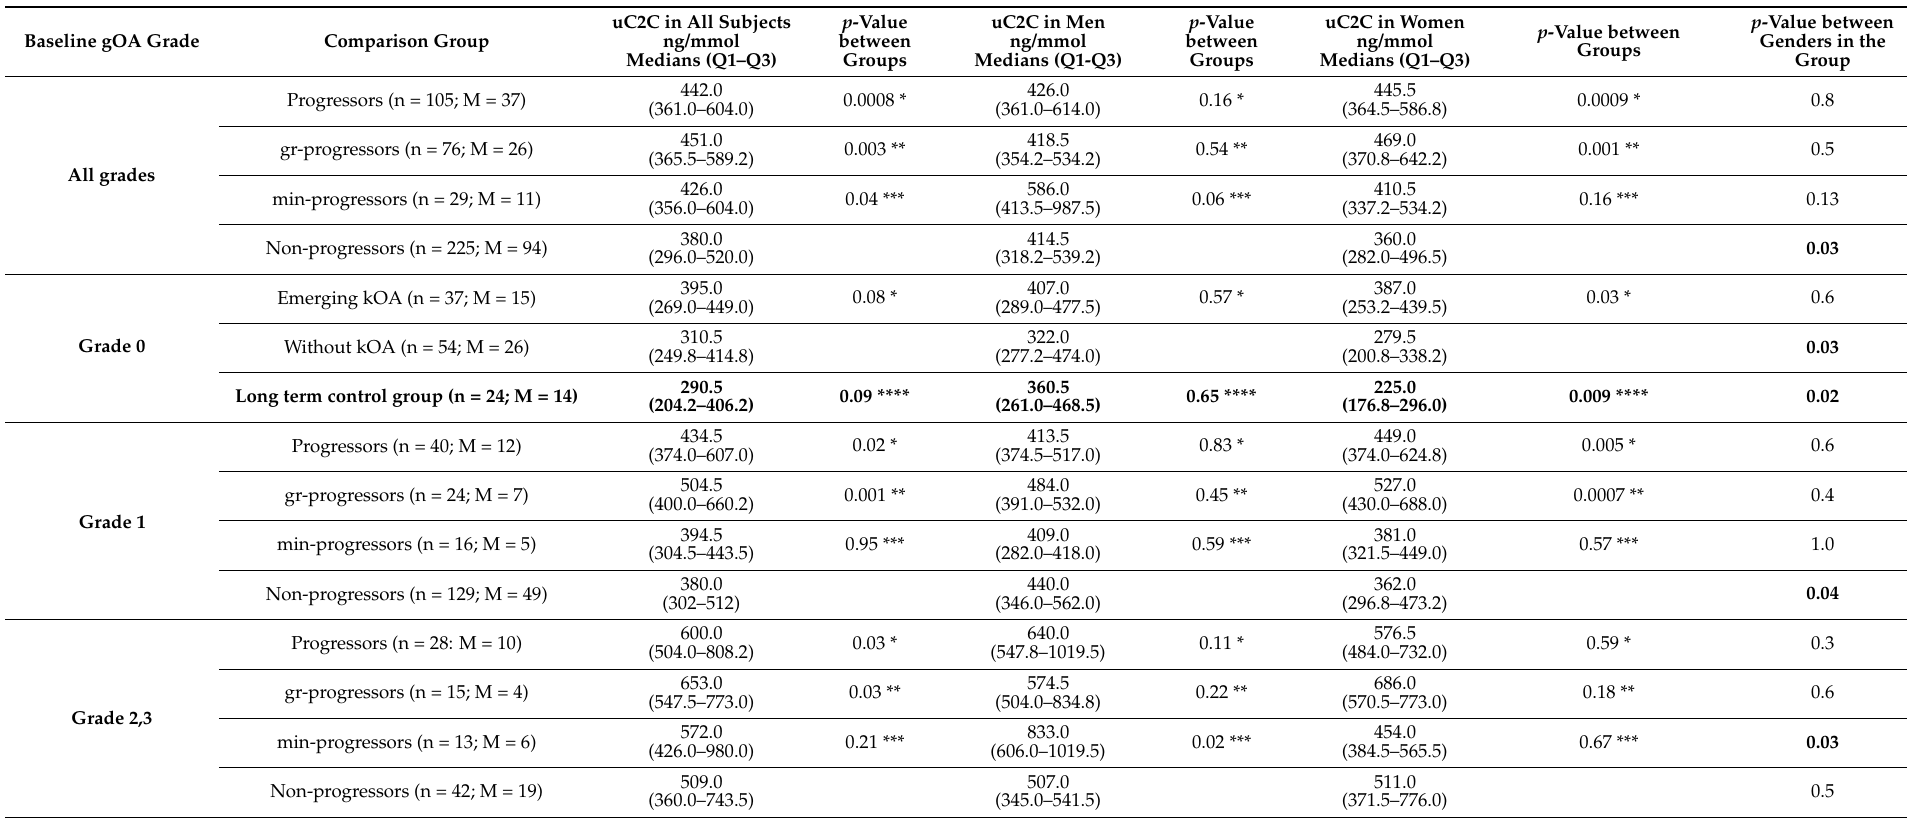
Table A1. The association of uC2C with radiographic progression of knee osteoarthritis (kOA). Radiographical changes are divided into grades according to the grading system by Nagaosa-Doherty